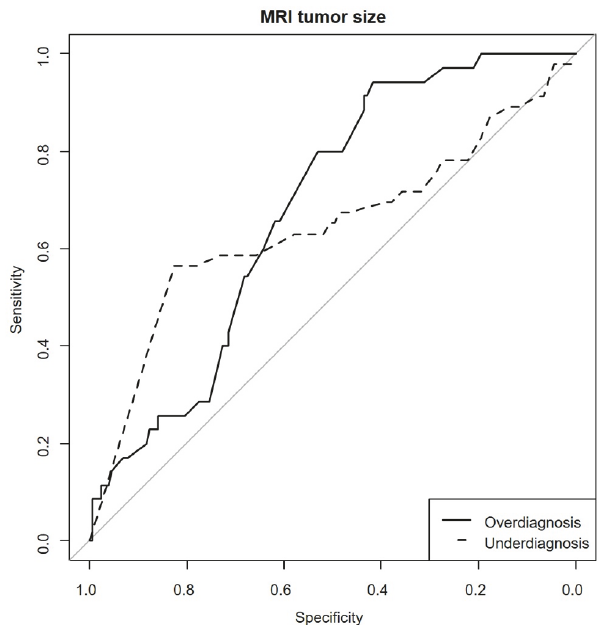
Figure 1: Comparison of finial pathologic stage versus multiparametric MRI radiologic stage versus clinical FIGO stage.